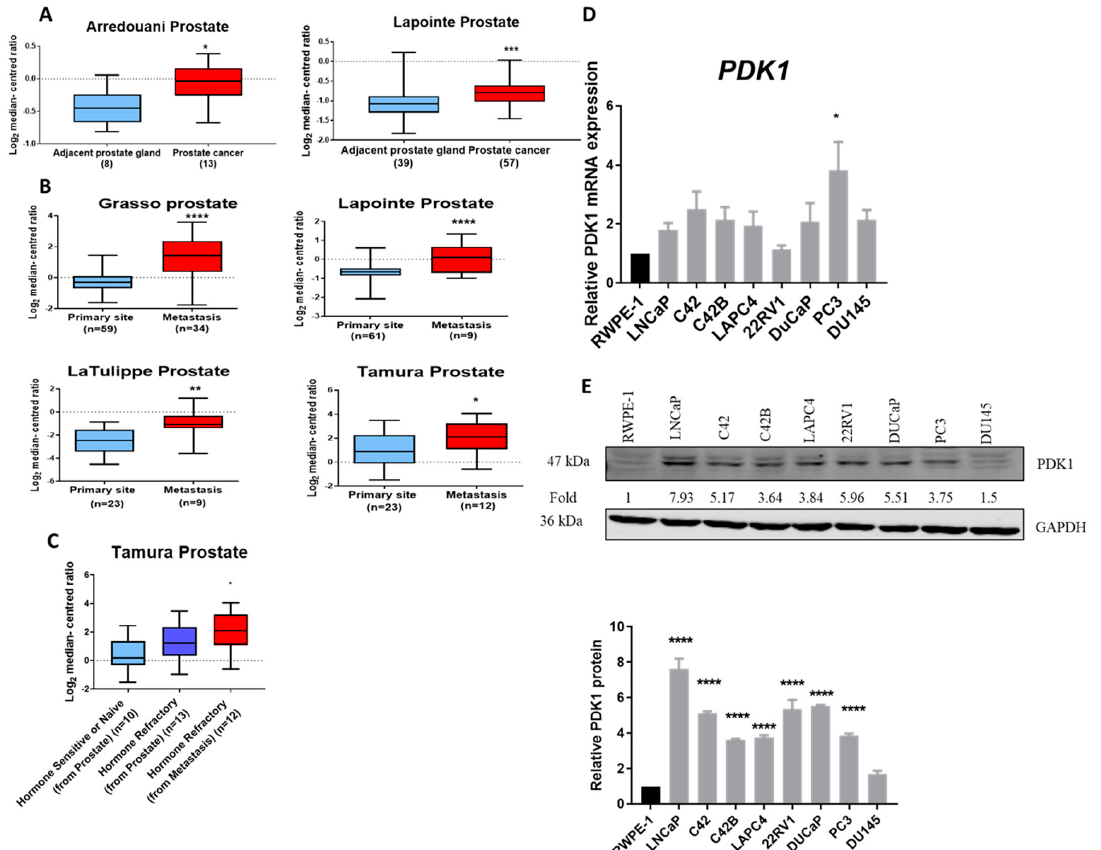
Figure 1. Increased PDK1 expression with disease progression. ( A ) Analysis from the Oncomine database indicated that PDK1 mRNA expression was upregulated in prostate carcinoma compared to the primary site in the Arredounai dataset ((adjacent prostate gland ( n = 8), prostate cancer ( n = 13)) and Lapointe dataset ((adjacent prostate gland ( n = 39), prostate cancer ( n = 57)). ( B ) PDK1 mRNA expression levels were significantly upregulated in metastasis compared with the primary site in four independent datasets (Grasso (primary site ( n = 59), metastasis ( n = 34)), Lapointe (primary site ( n = 61), metastasis ( n = 9)), La Tulippe (primary site ( n = 23), metastasis ( n = 9)) and Tamura (primary site ( n = 23), metastasis ( n = 12)). ( C ) Higher PDK1 mRNA was observed in patients with hormone refractory compared to naive. Tamura (hormone sensitive ( n = 10), hormone refractory from prostate ( n = 13), hormone refractory from metastasis ( n = 12)). ( D ) PC3 cells showed the highest PDK1 mRNA expression, which was significantly higher when compared to a cell line derived from normal prostate epithelial cells, RWPE-1. ( E ) PDK1 protein was upregulated in prostate cancer cell lines compared to RWPE1 cells. Statistically significant differences were assessed using an unpaired t -test ( A , B ), and one-way ANOVA with Tukey’s multiple comparison test ( C – E ) (**** p < 0.0001, *** p < 0.001, ** p < 0.01, * p < 0.05).